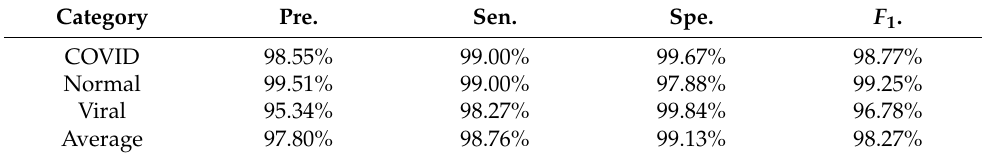
Table 7. Recognition results of the BoT-ViTNet model on the COVID-19 Radiography database.